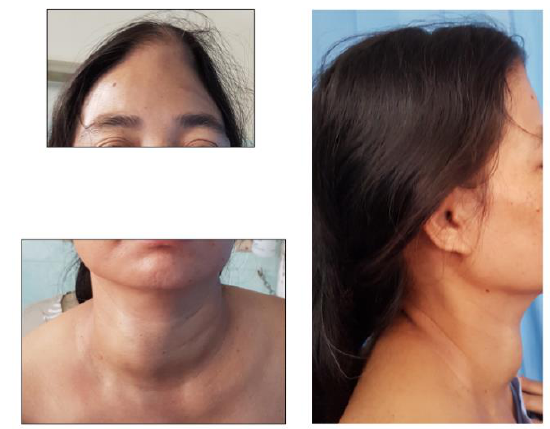
Figure 1. Clinical presentation of the skeletal lump in the frontal region.